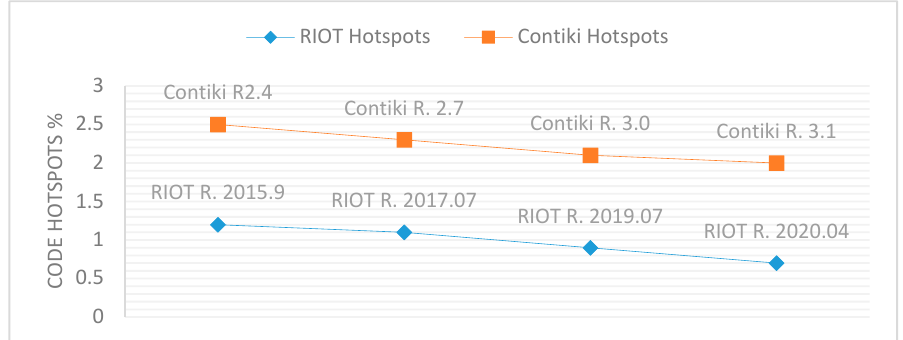
Figure 8. Hotspot evolution of RIOT and Contiki releases.